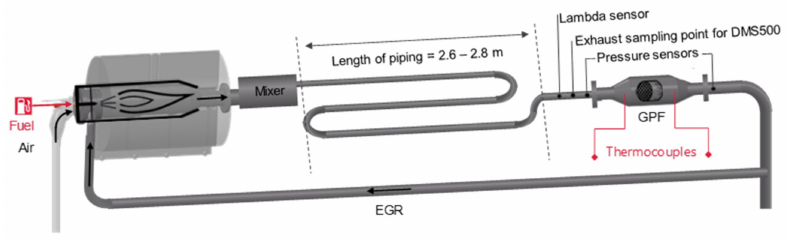
Figure 2. Schematic overview of burner test bench